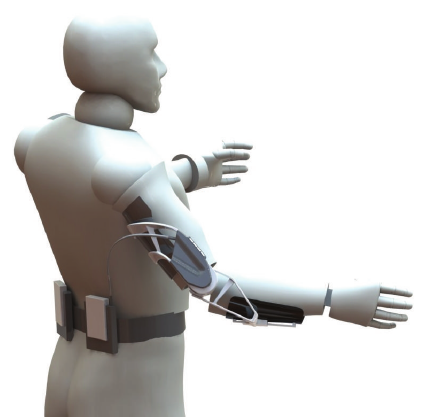
Figure 12: One possible redesign for the future version of the active orthosis—back